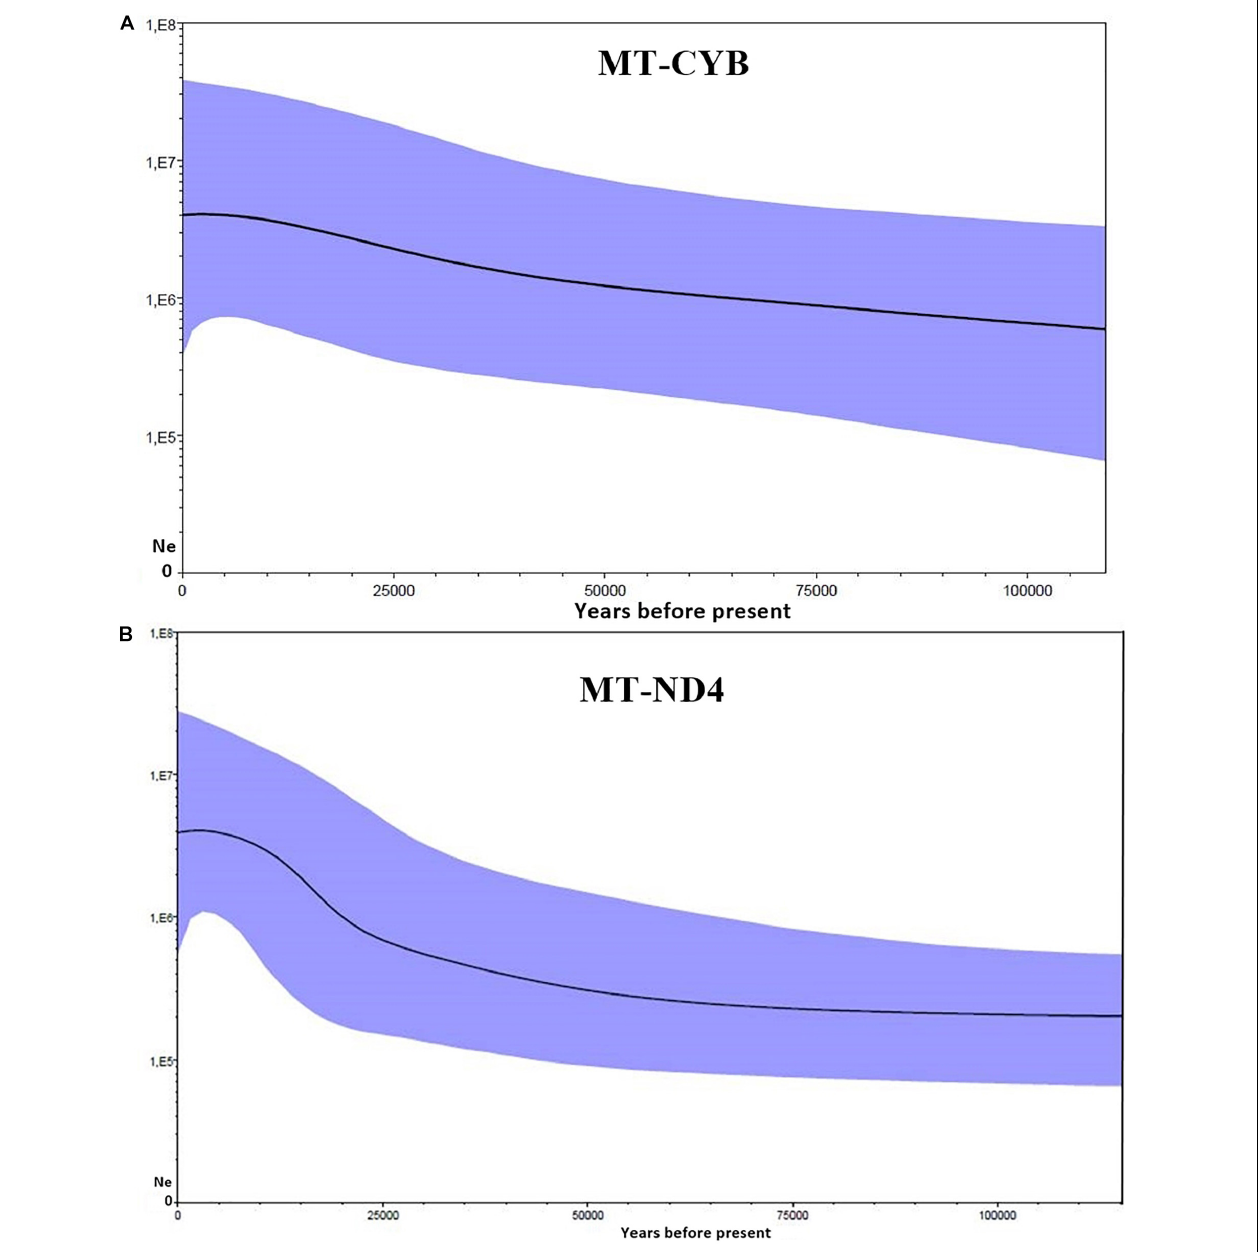
FIGURE 3 | Bayesian Skyline plots showing changes in the effective population size over time in Scomberomorus brasiliensis , based on mtDNA sequences. The x axis shows time before present in years, going backward from left to right. The y axis shows the effective population size. (A) The posterior distribution of the effective population size over time based on the MT-CYB gene at three Brazilian localities, and (B) The posterior distribution of the effective population size over time based on the MT-ND4 gene from seven localities in the western South Atlantic. The dark line represents the mean, and the blue band represents the 95% highest posterior